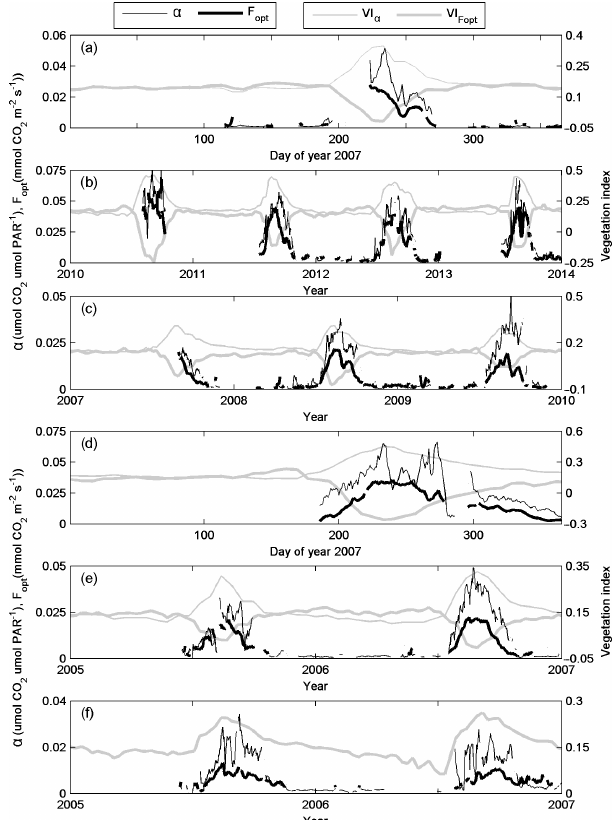
Figure 3. Time series of photosynthetic capacity ( F opt ) and quan- tum efficiency ( α) for the six measurement sites. Also included are time series of the vegetation indices with highest correlation with F opt (VI F ) and quantum efficiency (VI α ; Table 2). The sites are opt (a) Agoufou (ML-AgG), (b) Dahra (SN-Dah), (c) Demokeya (SD- Dem), (d) Kelma (ML-Kem), (e) Wankama Fallow (NE-WaF) and (f) Wankama Millet